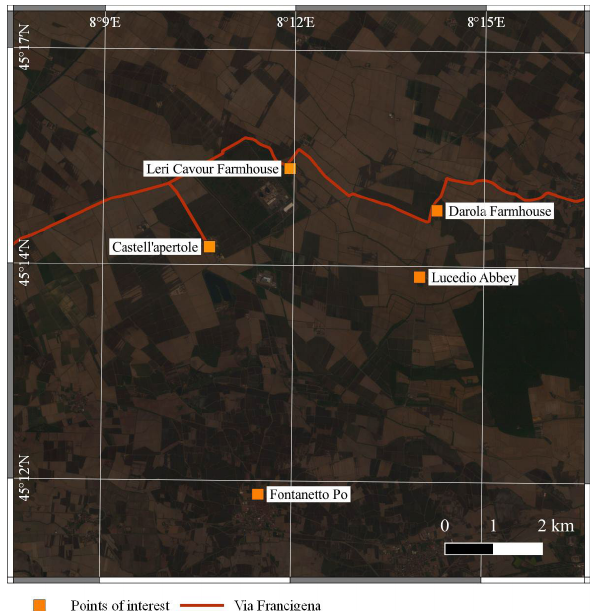
Figure 4. Satellite image of the area which has been selected for mapping the flooding of paddy-rice fields 24 th April 2021.